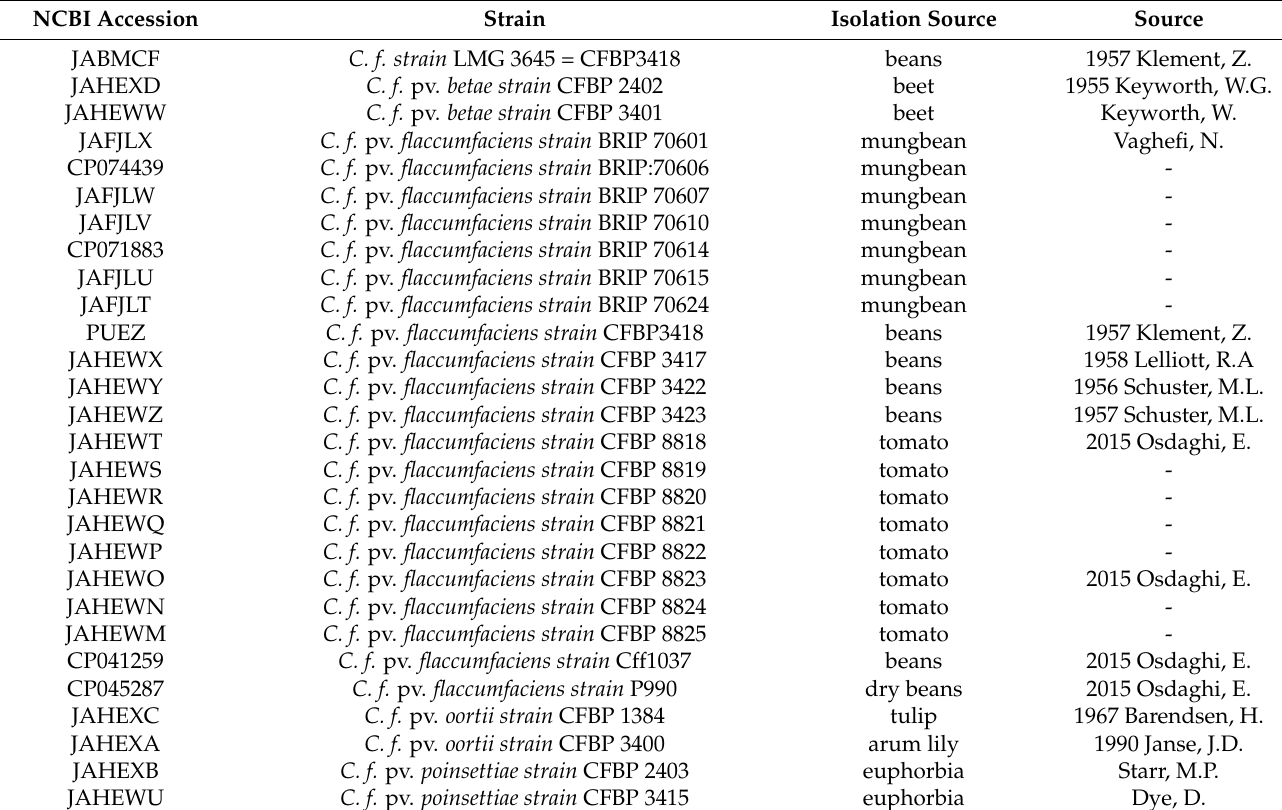
Figure 1. Statistics on 190 Curtobacterium genomes deposited in the NCBI database as of October 2021. It is difficult to estimate the number of C. flaccumfaciens pathogenic strains deposited in the genome database confidently, since the majority of the deposited strains have not been tested in biological experiments. However, the data available in the literature makes it possible to distinguish at least 28 pathogenic strains (Table 1). Table 1. Curtobacterium flaccumfaciens strains with confirmed